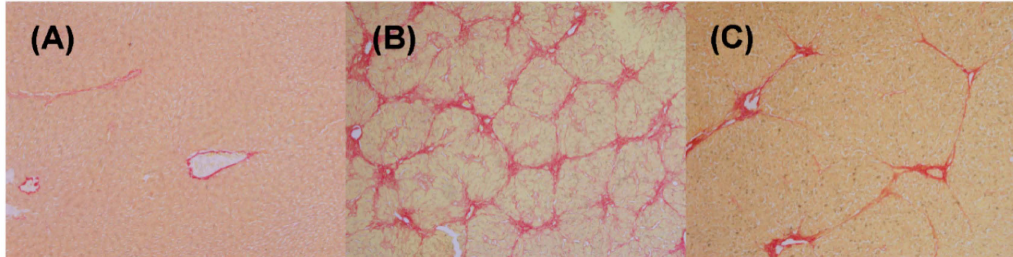
Figure 1. Representative histological photomicrographs of rat liver sections in the control ( A ); model ( B ) and YCHT group ( C ). Paraffin-embedded sections were stained with Sirius red (original magnification ˆ 200).